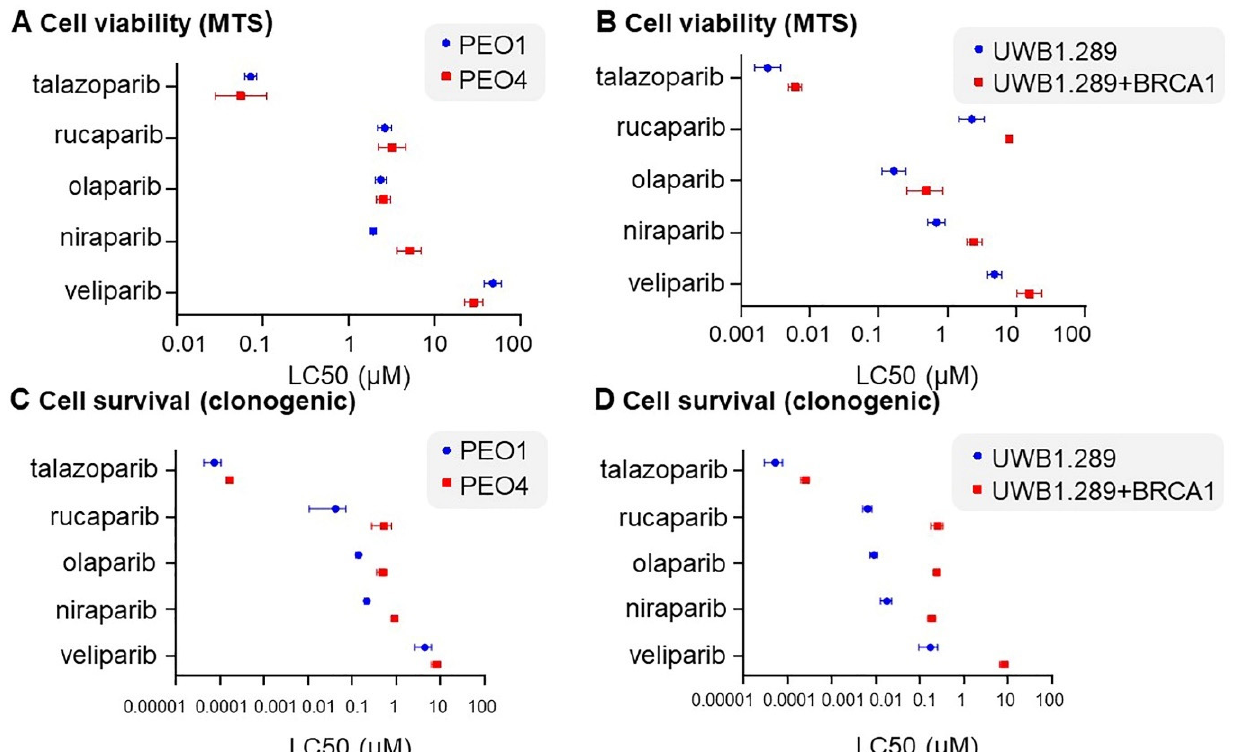
Figure 1. LC50 calculated from cell viability (MTS assay) data for each of five PARPis (talazoparib, rucaparib, olaparib, niraparib and veliparib) in ( A ) PEO1 and PEO4; ( B ) UWB1.289 and UWB1.289+BRCA1. LC50 calculated from cell survival (clonogenic assay) data for the identical five PARPis in ( C ) PEO1 and PEO4; ( D ) UWB1.289 and UWB1.289+BRCA1. Table 1. LC50 comparisons (cell proliferation; MTS) for PARPis in BRCA1/2 –WT paired HGSOC cell lines and a parental–veliparib resistant endometrioid ovarian cancer cell line.